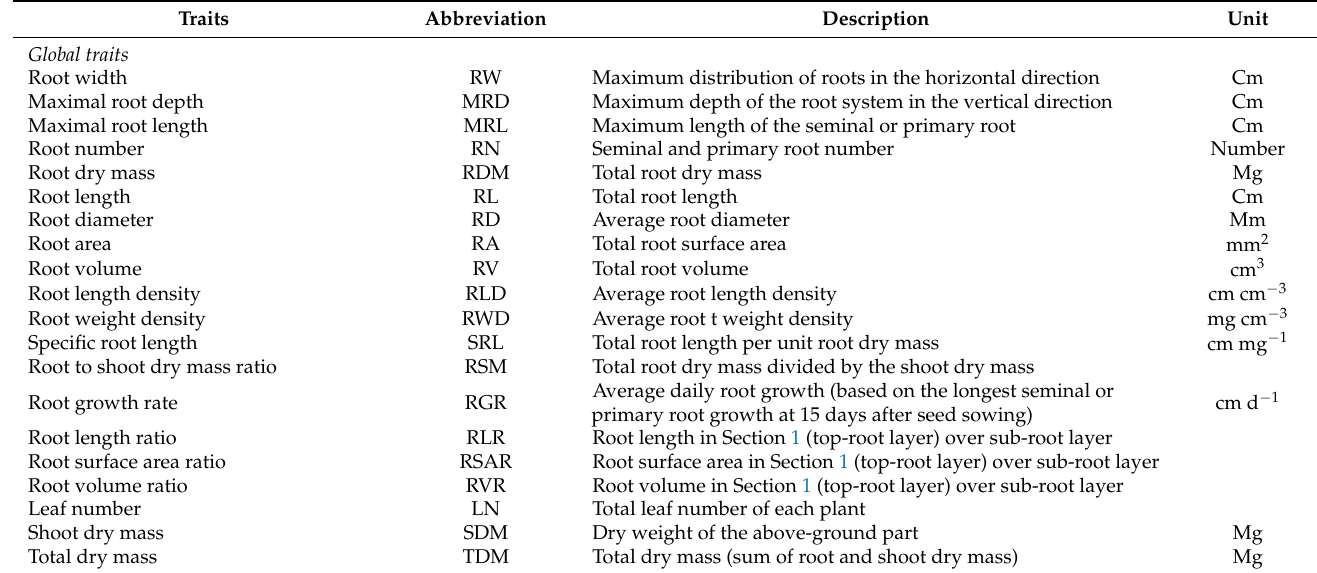
Table 1. Description of global traits and local traits in 65 millet